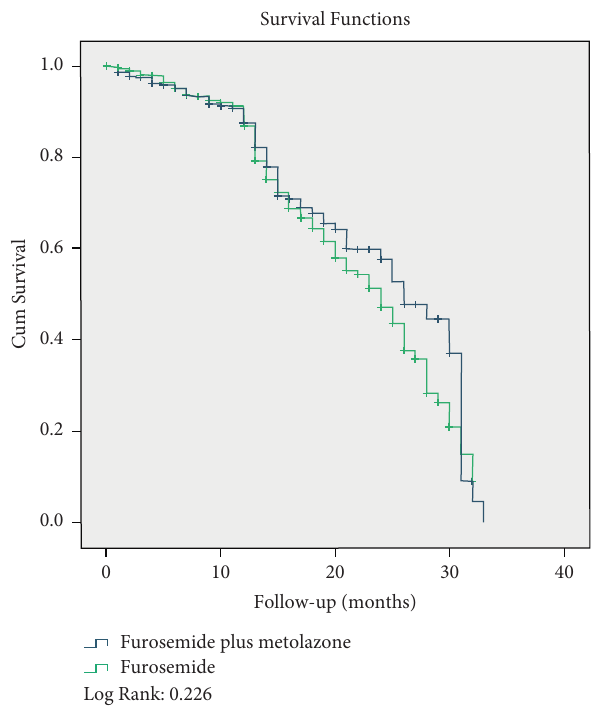
Figure 1: Survival curves for death according to different cate- gories of diuretic